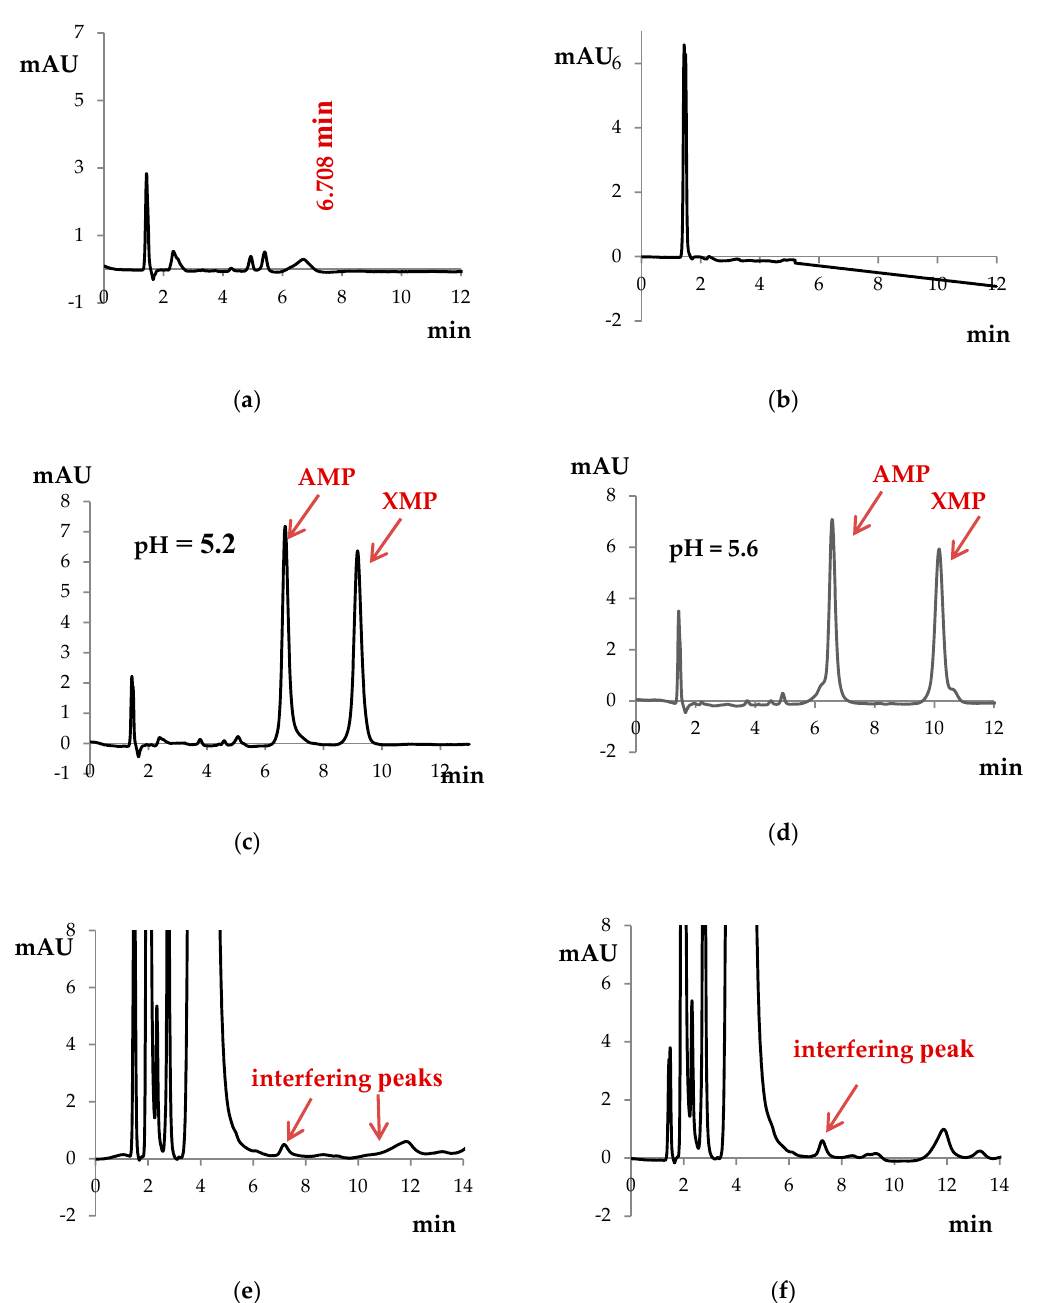
Figure 1. The HPLC chromatograms of ( a ) incubation bu ff er with bovine serum albumin (mobile phase bu ff er pH 5.2), ( b ) incubation bu ff er without bovine serum albumin (mobile phase bu ff er pH 5.2), ( c ) 10 µ moL / L of adenosine monophosphate (AMP) and 10 µ moL / L of xanthosine